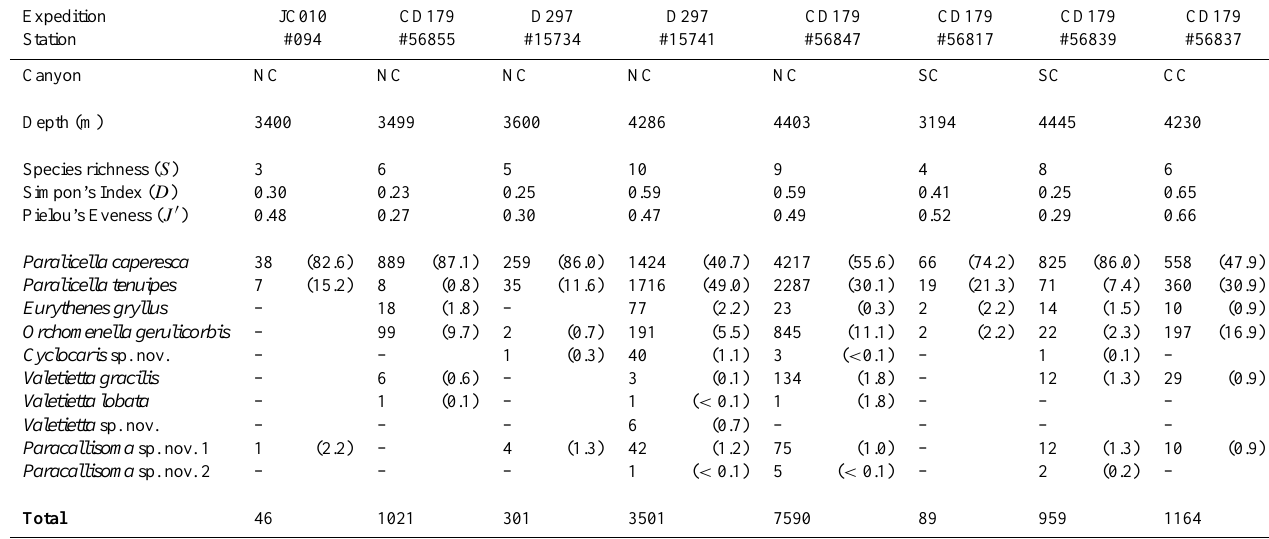
Table 3. Species composition and abundance (percentage contribution in parentheses) for scavenging amphipod component of samples collected from baited trap deployments in Iberian Margin submarine canyons (NC: Nazar´e Canyon, SC: Set´ubal Canyon; CC: Cascais Canyon). Species richness ( S ), Pielous’s Eveness ( J 0 ), and Simpson’s Diversity Index ( D )